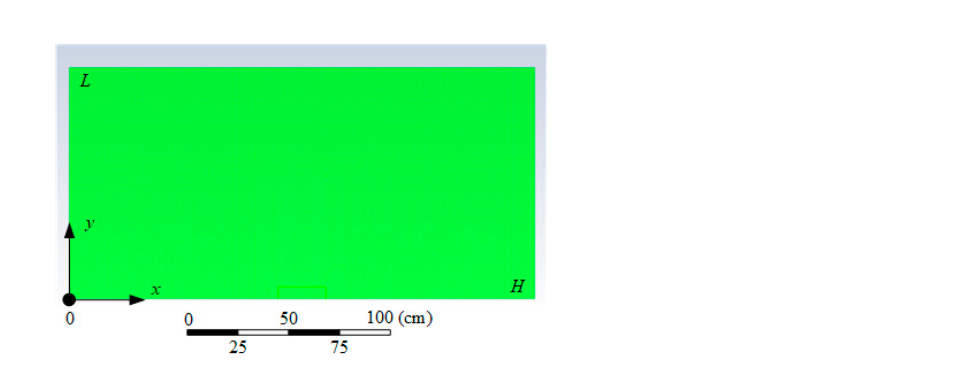
Figure 8. Scheme of the solution domain for heat transfer in the fire source–gas medium system. The interrelated processes of heat and mass transfer, as well as the physical and chemical transformations for the system under consideration (Figure 8), can be described by the following transient partial differential equations.